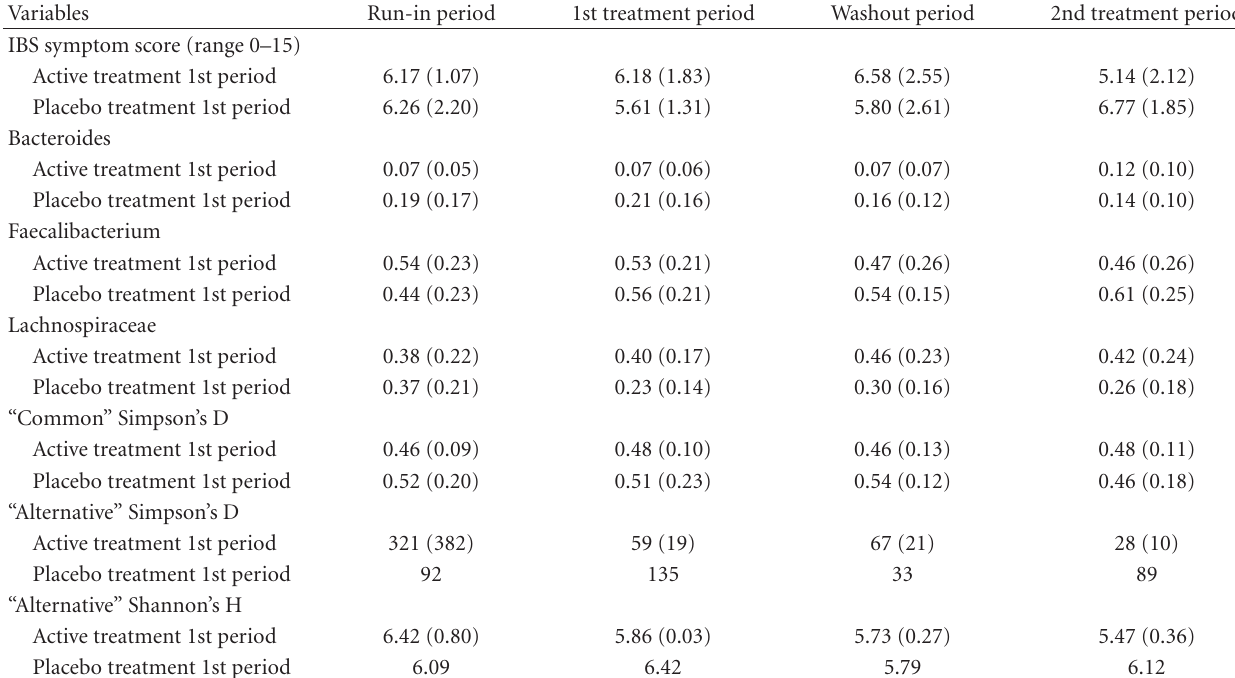
Table 1: IBS symptom scores, the relative proportion of the components of the fecal microbiota, and the diversity indexes in the four parts of the trial. Results are given as mean (SD).